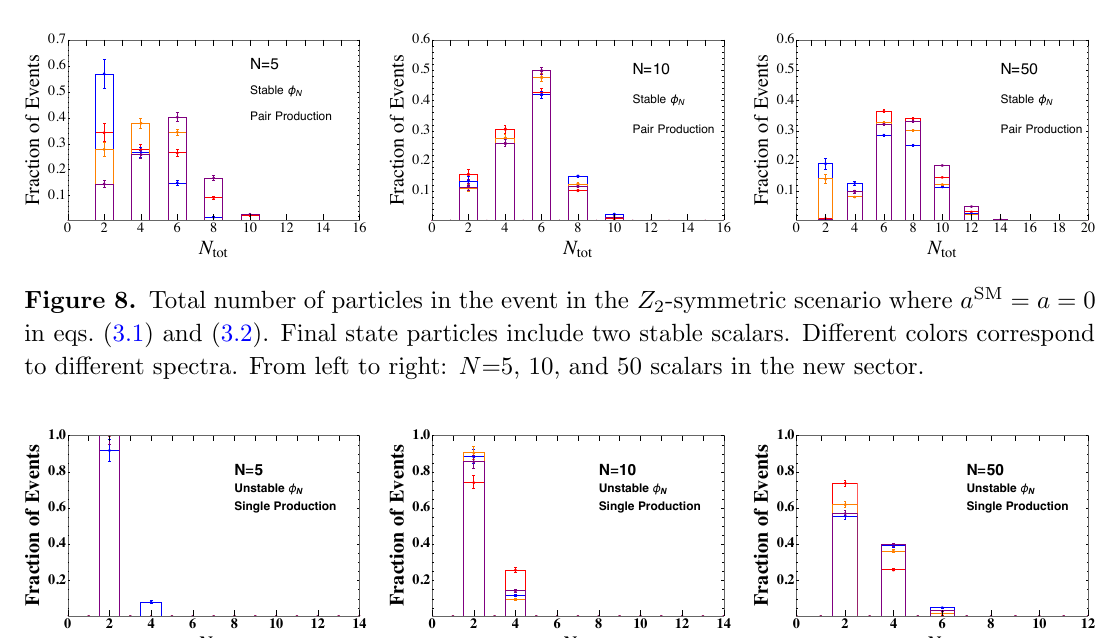
Figure 9. Total number of particles in the event in the scenario where all couplings in eqs. (3.1) and (3.2) are present and single production dominates. Di(cid:11)erent colors correspond to di(cid:11)erent spectra. From left to right: N =5, 10, and 50 scalars in the new sector.